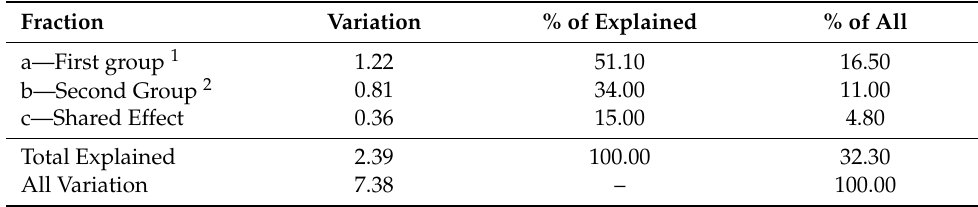
Table 2. Variation partitioning for environmental